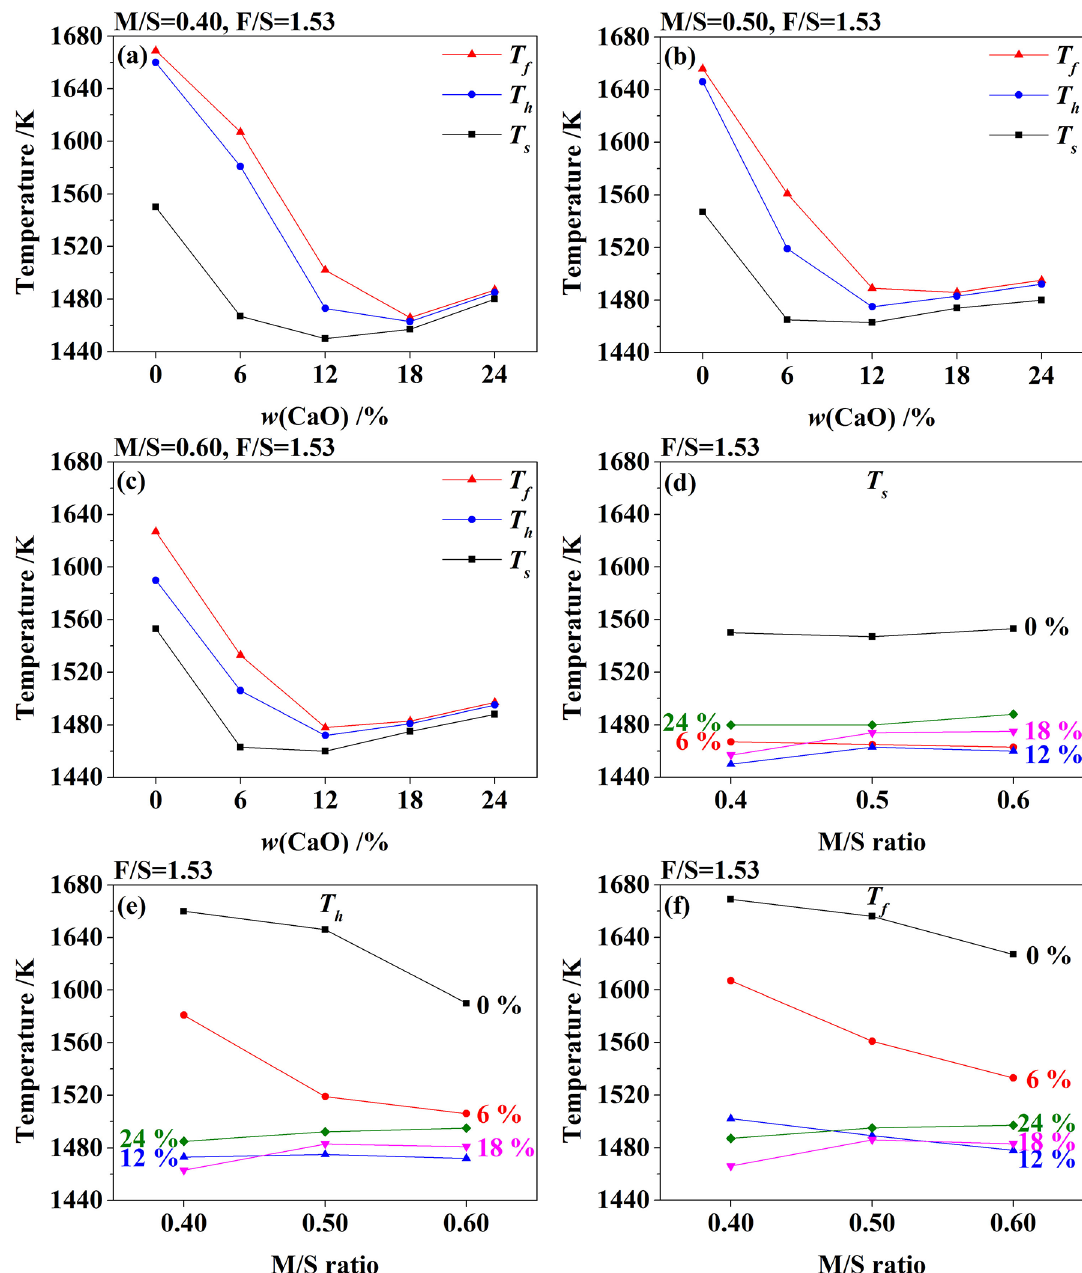
Figure 3. Influence of M/S and w (CaO) on the measured characteristic temperatures. Material (Figure S1 and Figure S2), and that of samples with M/S=0.40 and M/S=0.60 when F/S was 1.53 were also described in detail in Supplementary Material (Figure S3 and Figure